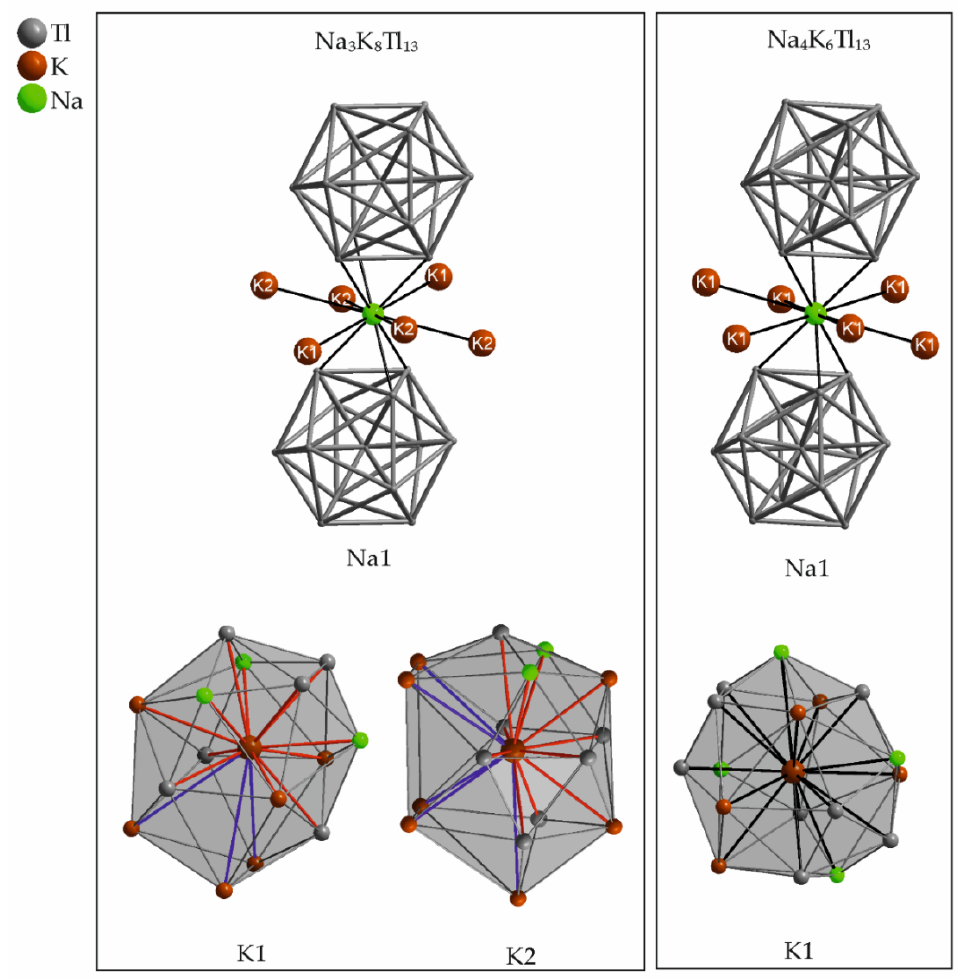
Figure 8. Atomic environment of the symmetry inequivalent sodium and potassium position(s) in Na 3 K 8 Tl 13 and Na 4 K 6 Tl 13 . The corresponding range of distances to the adjacent atoms as well as